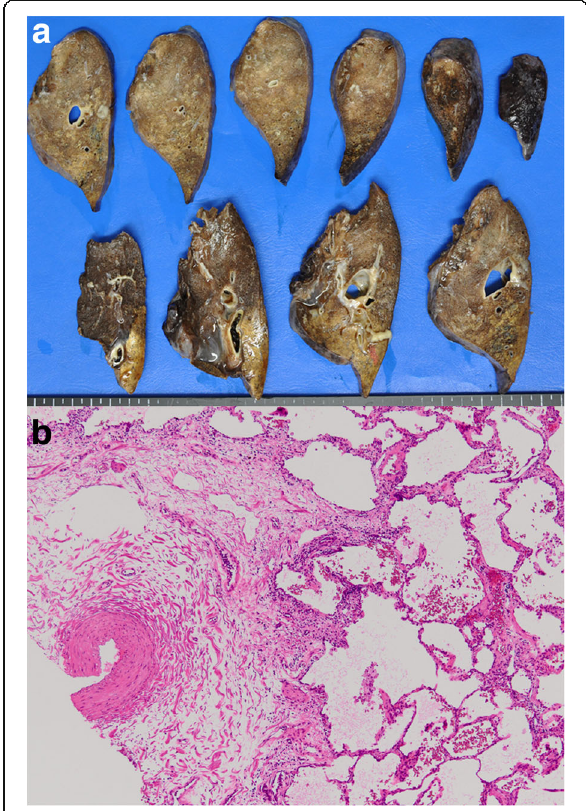
Fig. 3 Histopathological findings. a Macroscopic specimen showing multiple cystic lesions with a boundary and elastic artery flow into that area. b Hematoxylin and eosin (HE) staining showing fibrous thickening of the alveolar wall, glandular squamous metaplasia, and a lymphoid follicle structure caused by repeated